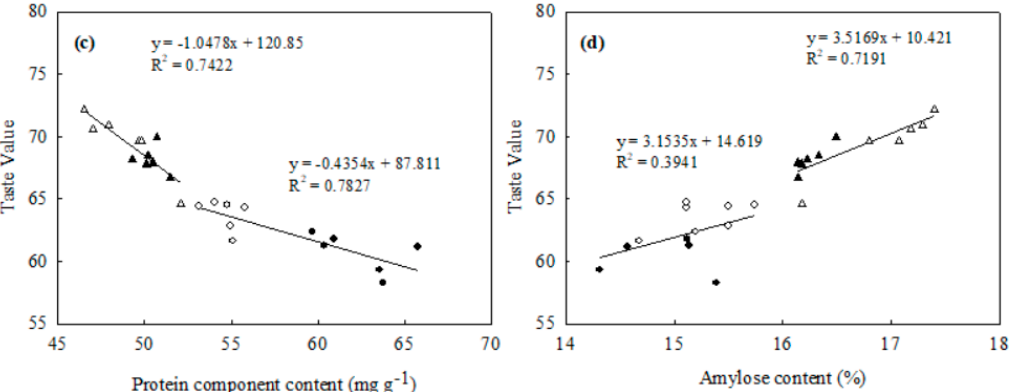
Figure 5. Correlation analysis of taste value and head rice rate ( a ), chalkiness rate ( b ), protein component content ( c ) and amylose content ( d ) of different rice varieties under shading after flowering in 2020–2021. YLY900 (Y-liangyou 900); QYHZ (Quanyouhuazhan); YY1540 (Yongyou 1540); YY538 (Yongyou 538).